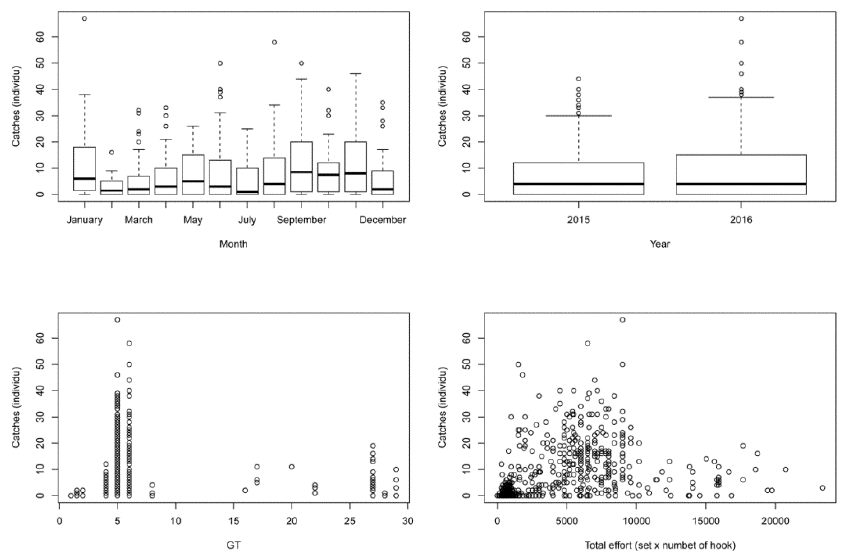
Figure 4. Comparison between sharks caught by different month ( top left ), by different year ( top right ), by different vessel sizes ( bottom left ) and by different total effort (set x number of hook) ( bottom right ). Data was represented using boxplots for the categorical variables (month and